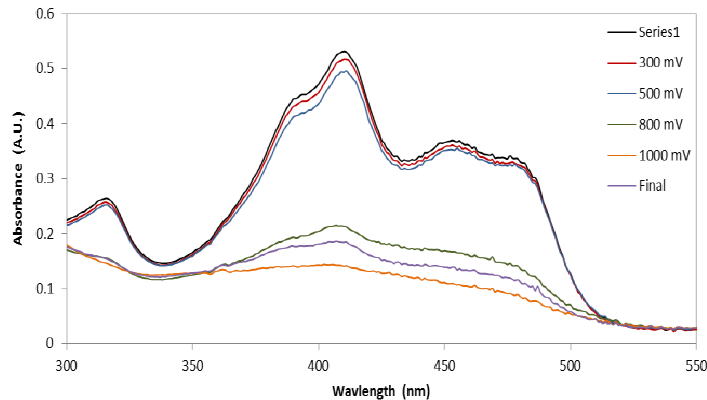
Figure 14. Overlaid spectrum of +2Zn2 hydrazone in acetonitrile as it is oxidized to 1 V and swept back to its initial potential. The characteristic shape and peaks of the complex’s optical absorption tend to diminish between positive 600−700 mV, and it seems as if the complex is not reversible due to the vast differences in the spectrum between the initial and final spectrum.